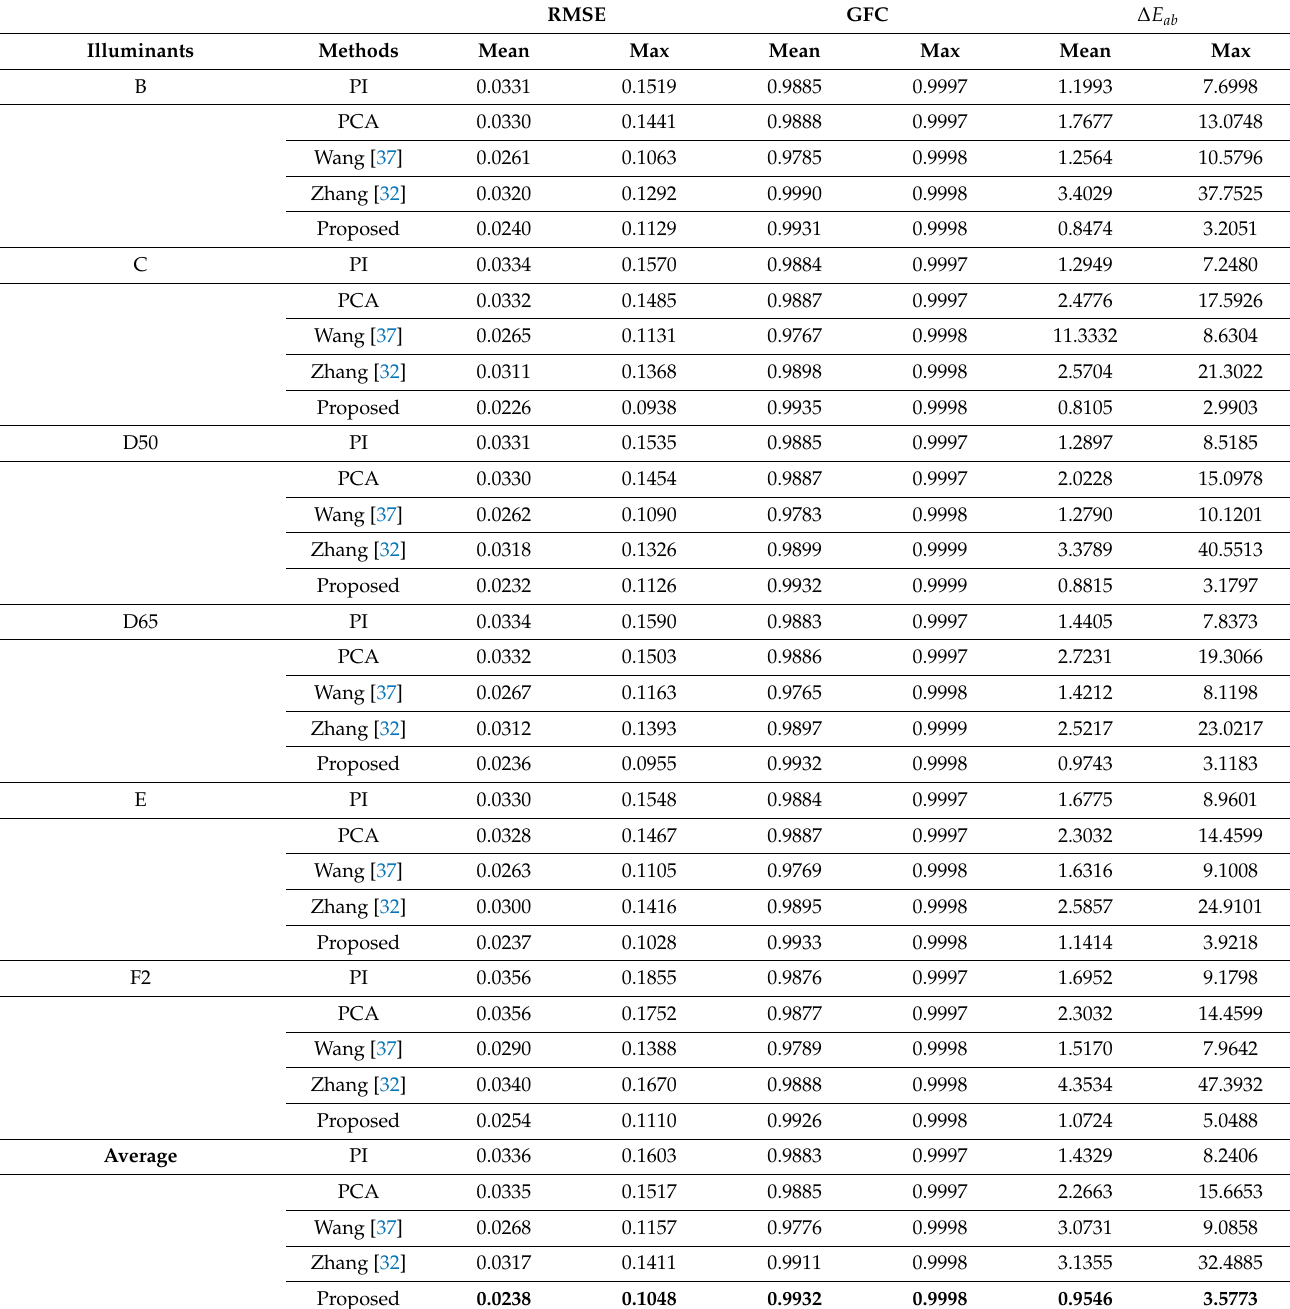
Table 4. Results of recovery spectral reflectance for different illuminants using different spectral recovery methods and NokiaN900 spectral sensitivity function. RMSE GFC